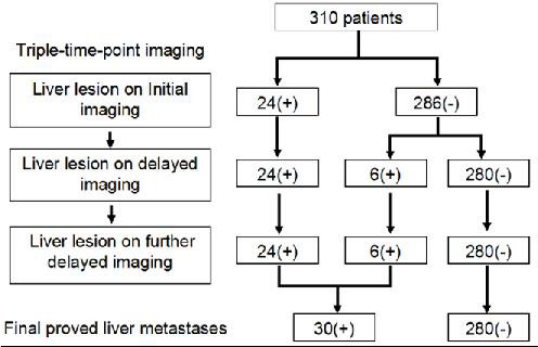
Figure 1. Flow chart demonstrating enrolled patients and their reporting. Of the total 310 patients, 286 patients had negative initial liver PET / CT imaging, six of the 286 patients had liver lesions on delayed imaging and further delayed imaging, and the other 24 patients exhibited liver lesions on initial imaging as well as delayed imaging. A total of 30 patients had liver metastases.